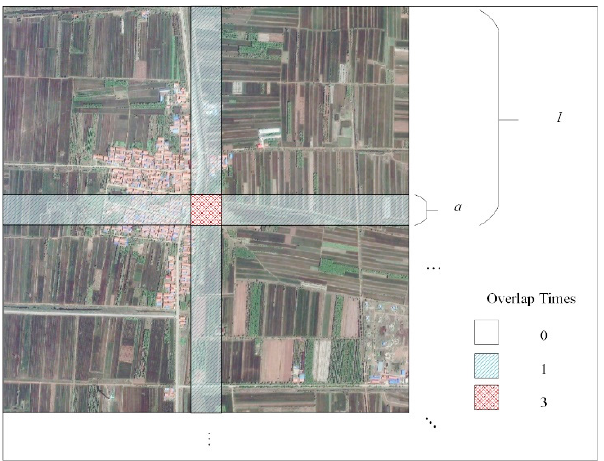
Figure 12. The strategy of smooth overlap of moving sliding windows.